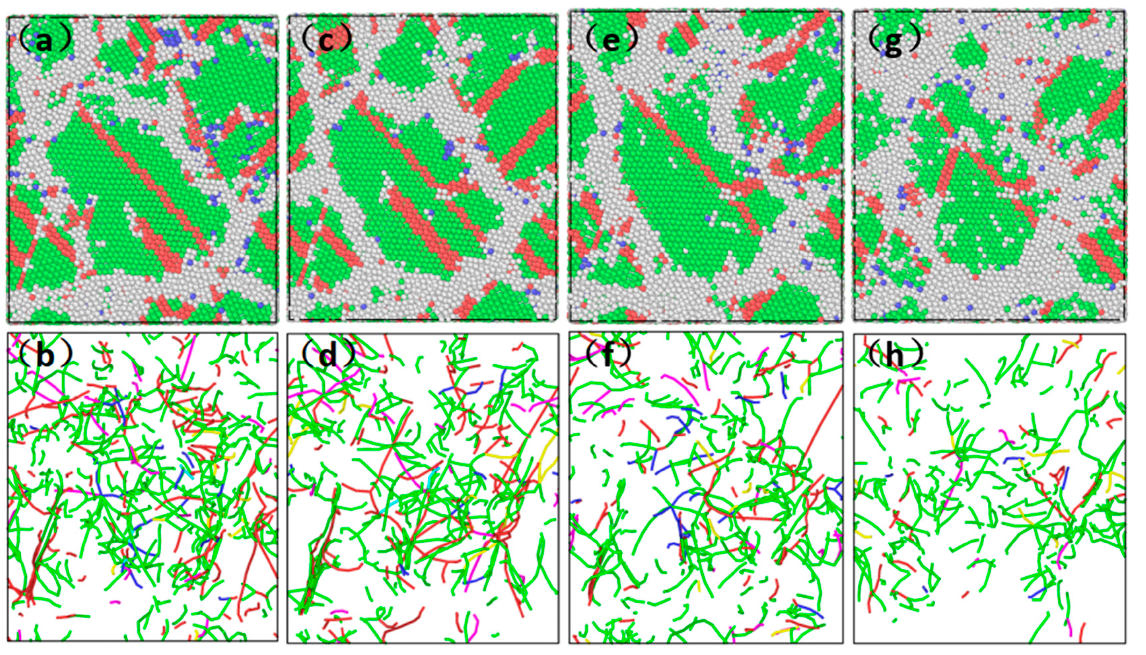
Figure 13. Structure and dislocations of CoCrNi samples with λ = 3.08 nm at 10% strain at 77 K ( a , b ), 300 K ( c , d ), 500 K ( e , f ), and 800 K ( g , h ).